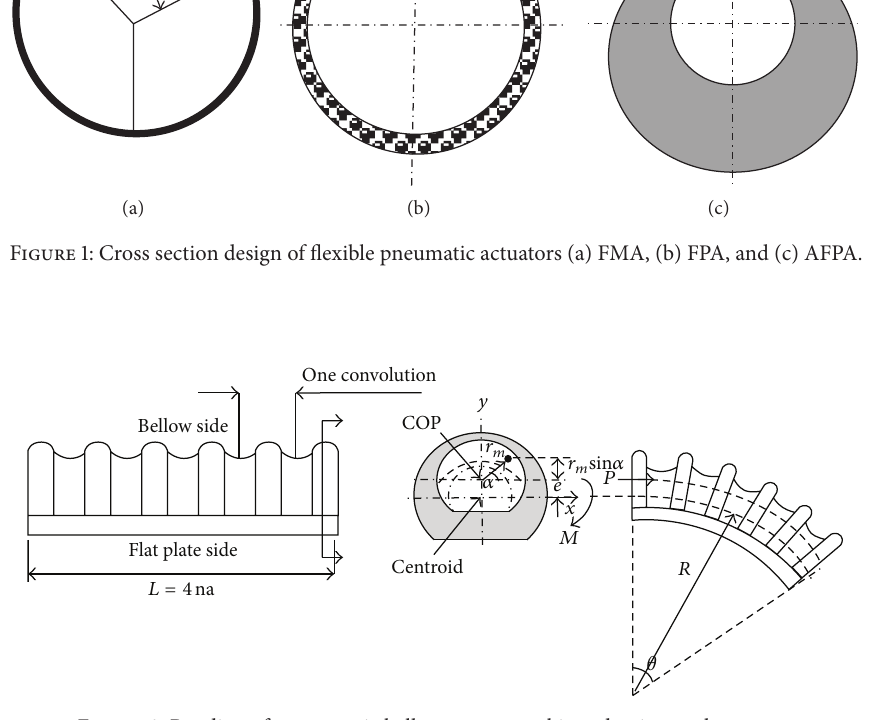
Figure 2: Bending of asymmetric bellow actuator subjected to internal